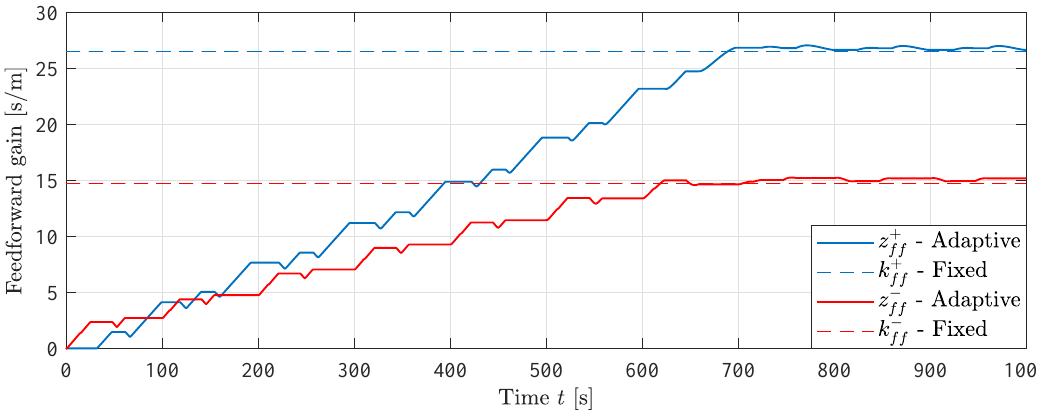
Figure 20. Feedforward states during sign-sign feedforward simulation, γ = 0.1 m − 1